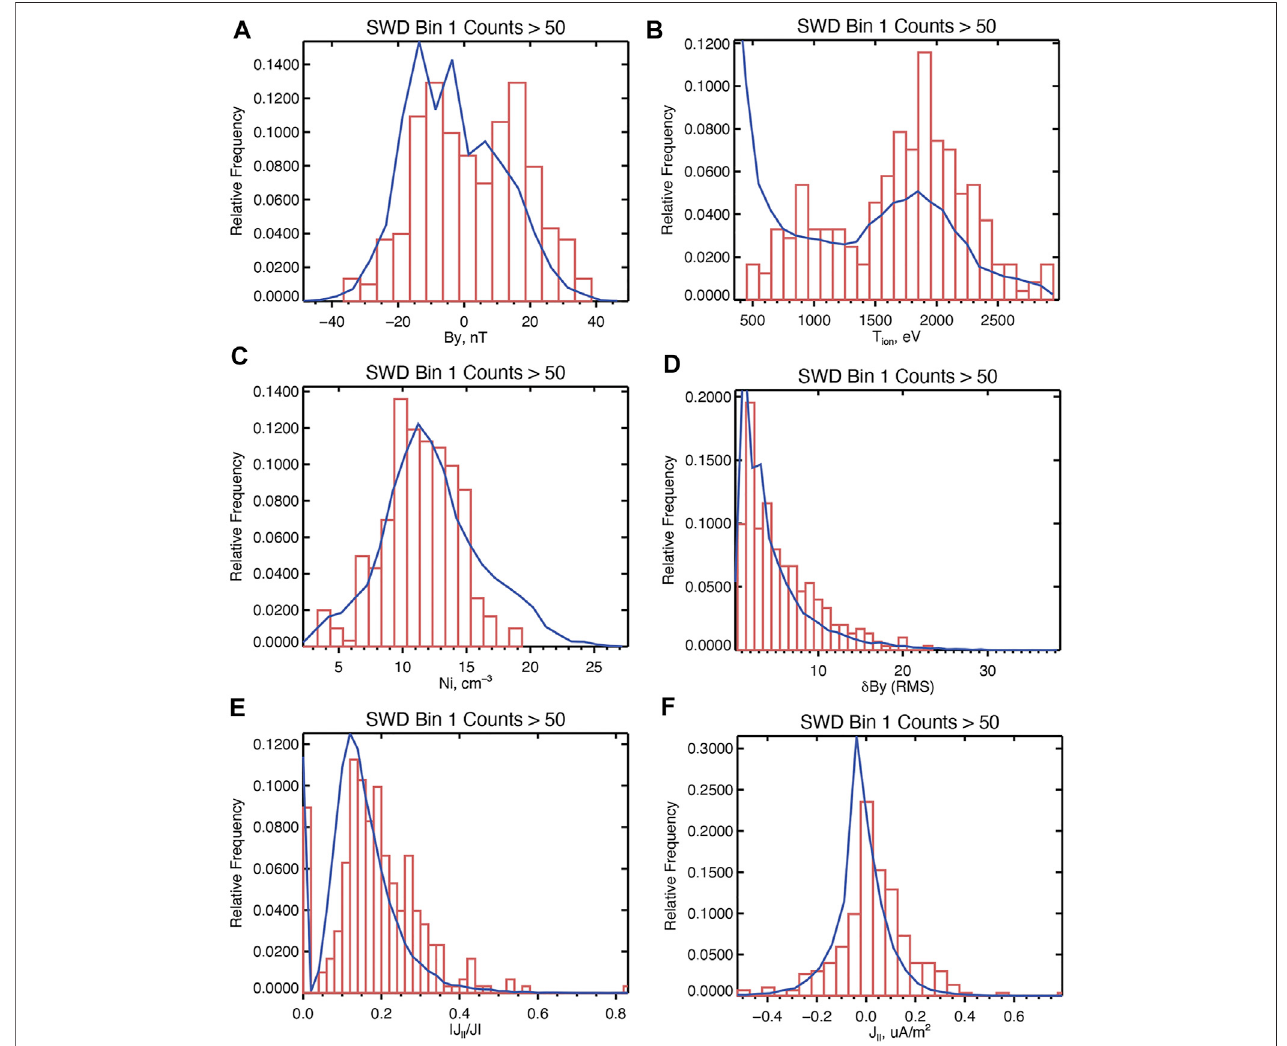
FIGURE 4 | Histograms of magnetic fi eld and plasma quantities during the September 8, 2015 burst interval for (red bars) 1s intervals with SWD bin1 counts greater than 50 and (blue line) all 1s intervals during the burst selections. (A) Magnetic fi eld GSE B Y , (B) Ion temperature, T ion , (C) Ion number density, N i , (D) δ B Y,RMS , (E) |J (cid:1) /J|, (F) J (cid:1)